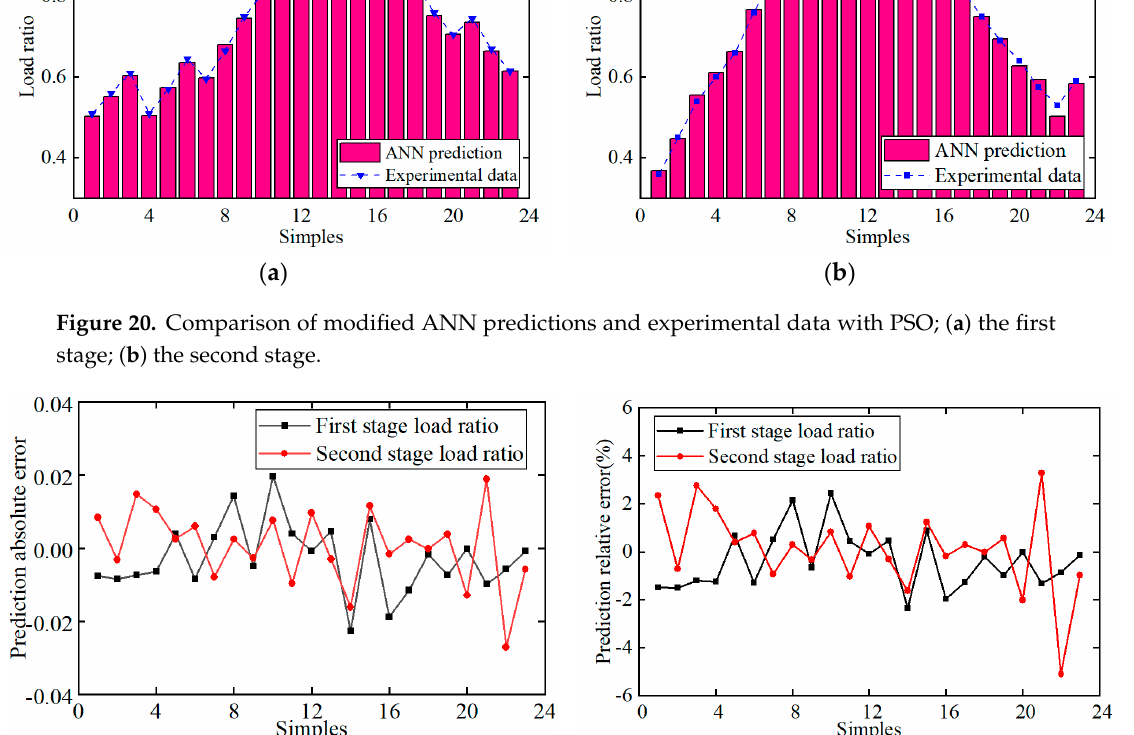
Figure 20. Comparison of modified ANN predictions and experimental data with PSO; ( a ) the first stage; ( b ) the second stage.